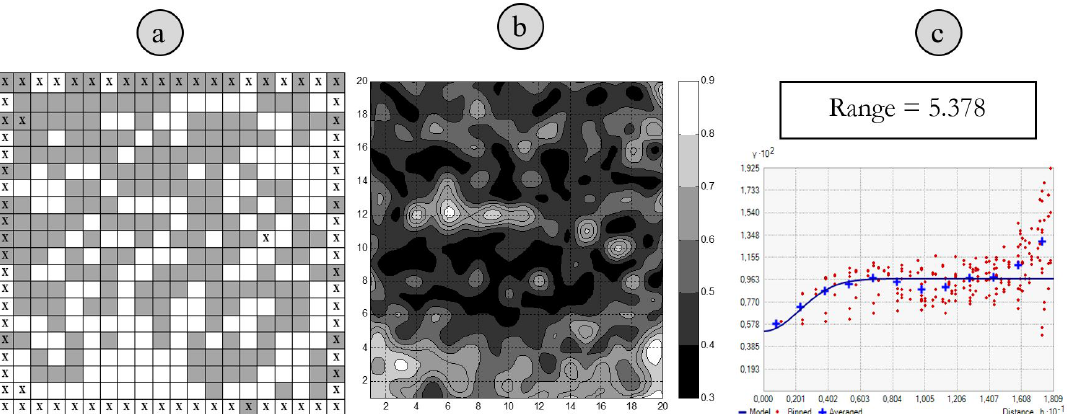
Figure 9. a) Location of points, b) Spline interpolation of data in the Matlab software, c) semivariogram obtained with